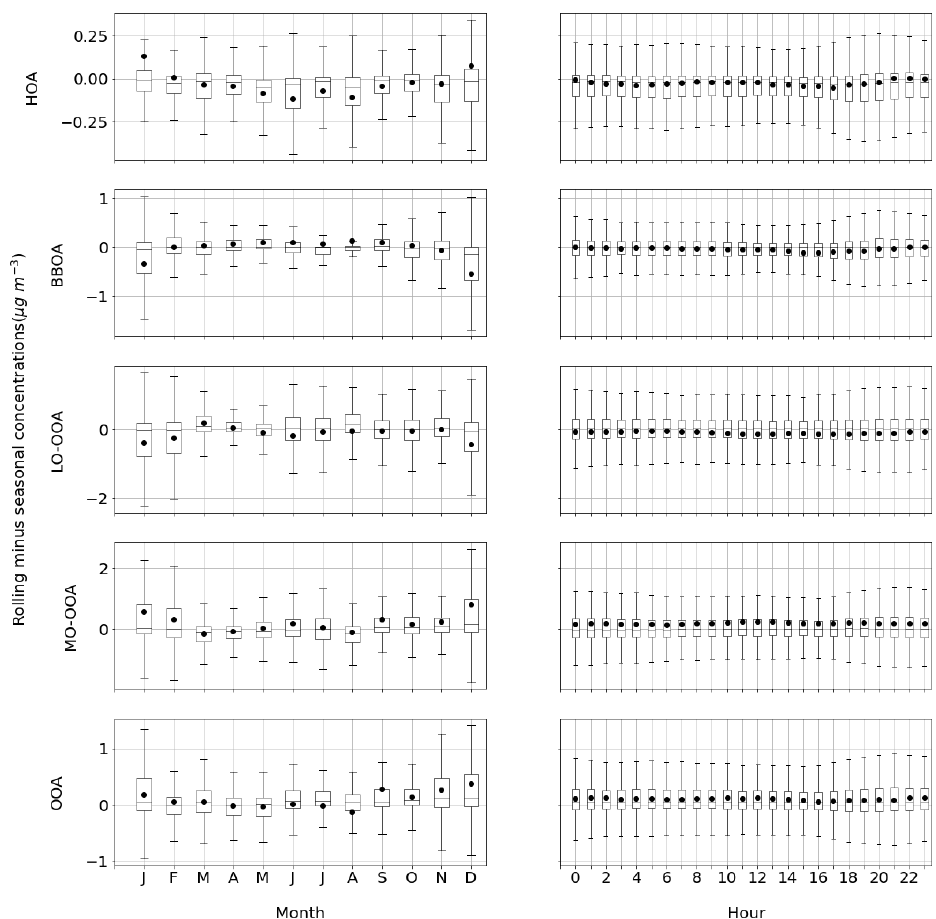
Figure 5. Boxplots of rolling minus seasonal factor absolute concentrations (in µgm − 3 ) per month and hour. Boxes show the Q1–Q3 range with the median (horizontal line) and the average (full circles); whiskers extend up to the range of the